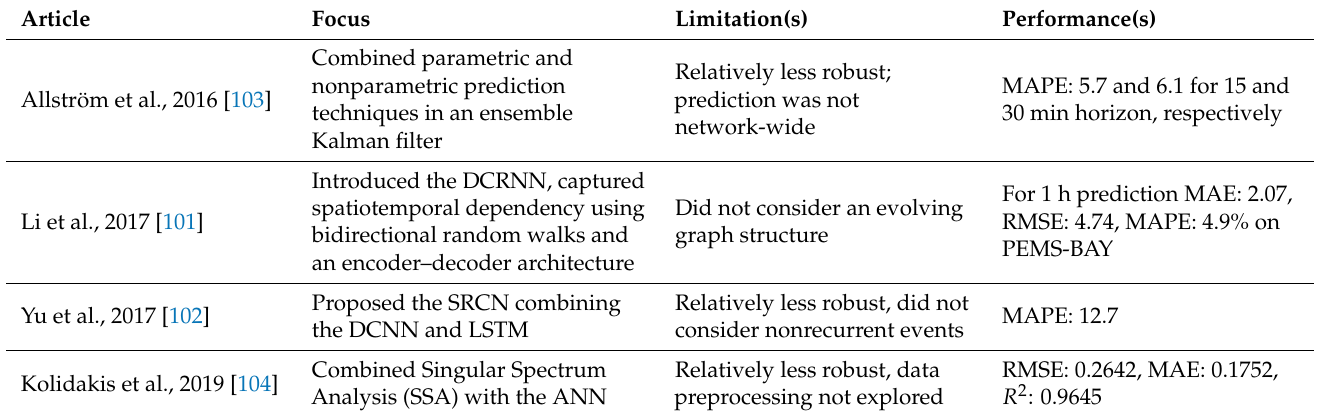
Table 17. Summary of the reference works on hybrid schemes.